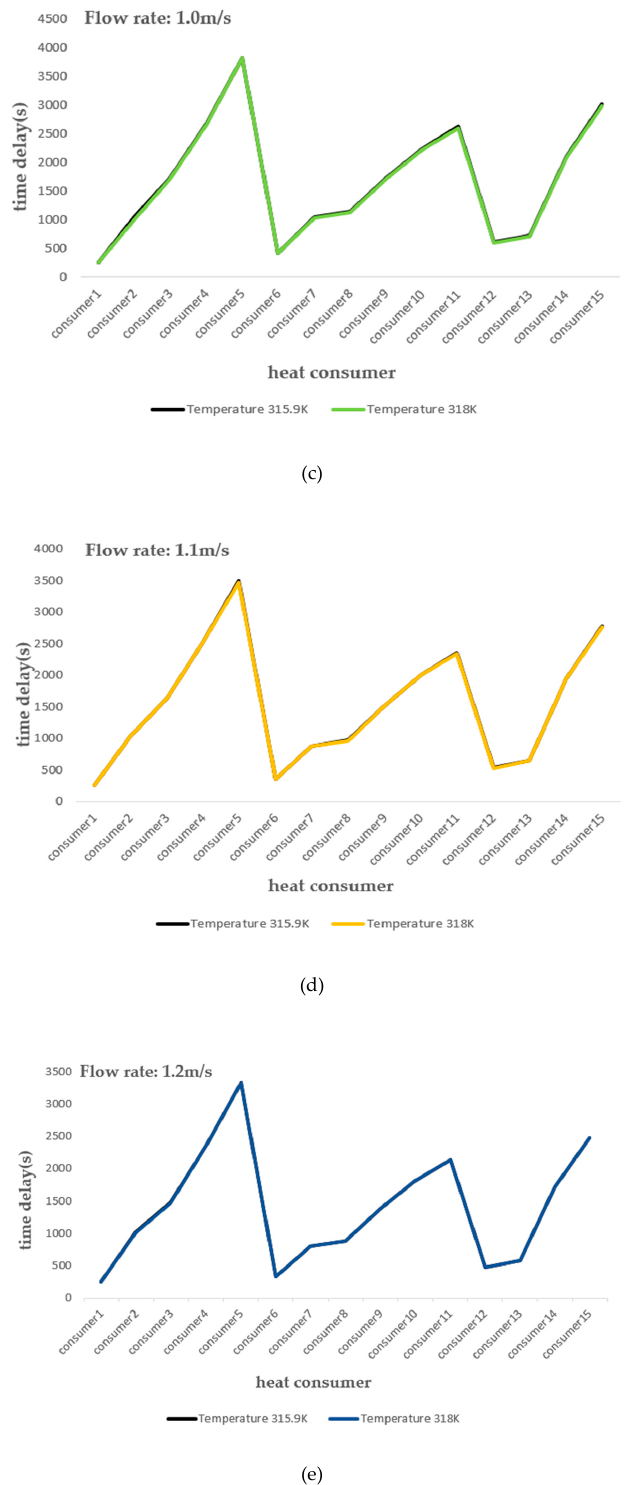
Figure 11. ( a ) Comparison of the time delay obtained by the two different temperature simulations under the condition of 0.8 m/s; ( b ) Comparison of the time delay obtained by the two different temperature simulations under the condition of 0.9 m/s; ( c ) Comparison of the time delay obtained by the two different temperature simulations under the condition of 1.0 m/s; ( d ) Comparison of the time delay obtained by the two different temperature simulations under the condition of 1.1 m/s; ( e ) Comparison of the time delay obtained by the two different temperature simulations under the condition of 1.2